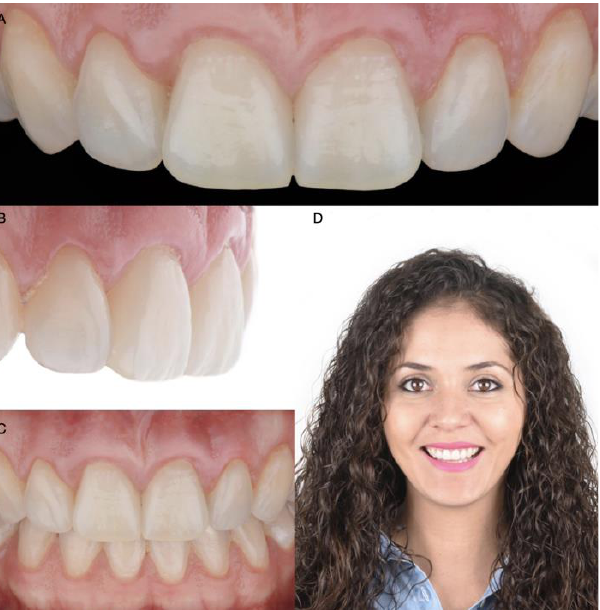
Figure 9. Final restorations: ( A ) Frontal view; ( B ) Lateral view; ( C ) Frontal in occlusion; ( D ) Final smile.